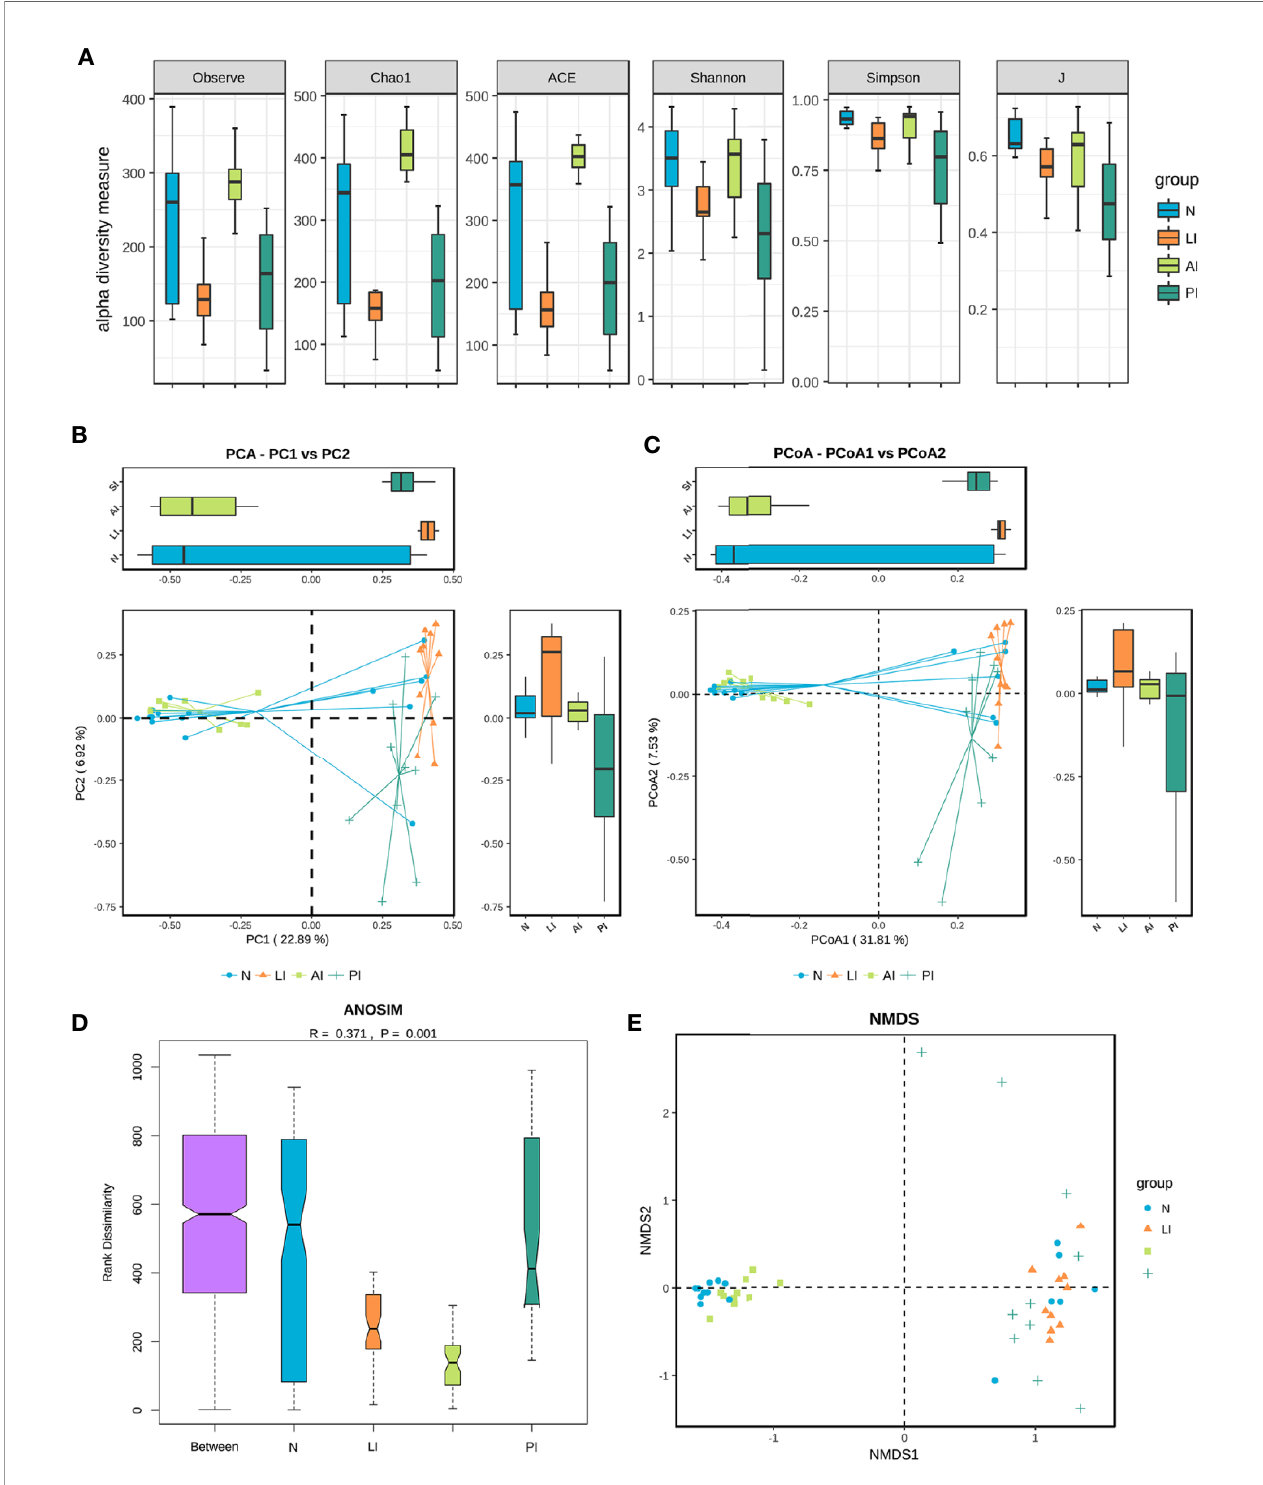
FIGURE 2 | (A) Gut microbioticalpha and beta diversity indices ofischemic stroke patients. The Observed_species, Chao1, ACE, Shannon,Simpson andJ index values. (B) PCA scores based on the relative abundances of OTUs (at the 97% similarity level). (C) PCoA analysisbased on weighted Unifracdistances. (D) Analysisof similarities. (E) Non-metric multi-dimensional scaling. Each dot represents a sample; the group isidenti fi ed inthe legend. In the graphs, closer samples are more